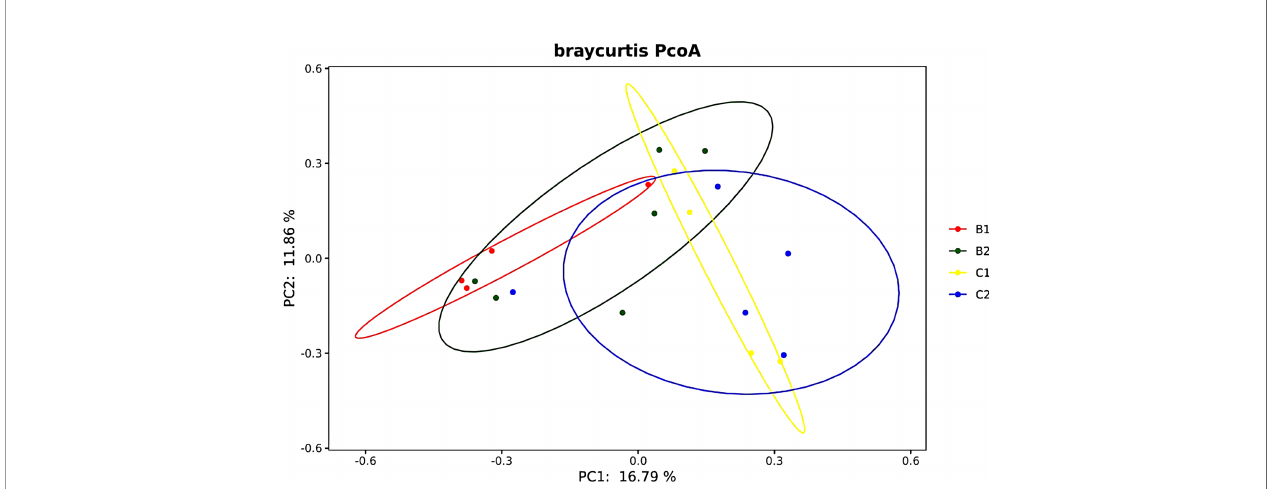
FIGURE 7 | Diagram of the Bray – Curtis distance principal coordinate analysis.